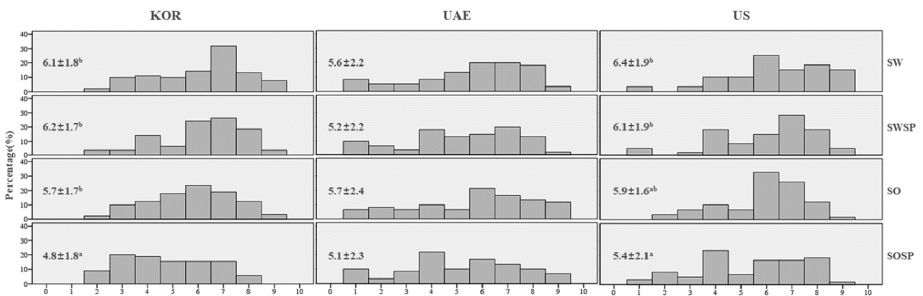
Figure 3. Histogram of overall liking ratings (mean ± SD) of spicy dipping sauce samples evaluated by KOR, UAE, and US consumers. KOR, UAE, US denote South Korean, United Arab Emirates, and Americans, respectively. ‡ Samples sharing the same superscript letters within the same country do not differ significantly among the products ( α = 0.05). § SW, SO, SWSP, and SOSP denote sweet, sour, spicy + sweet, and spicy + sour sample, respectively.